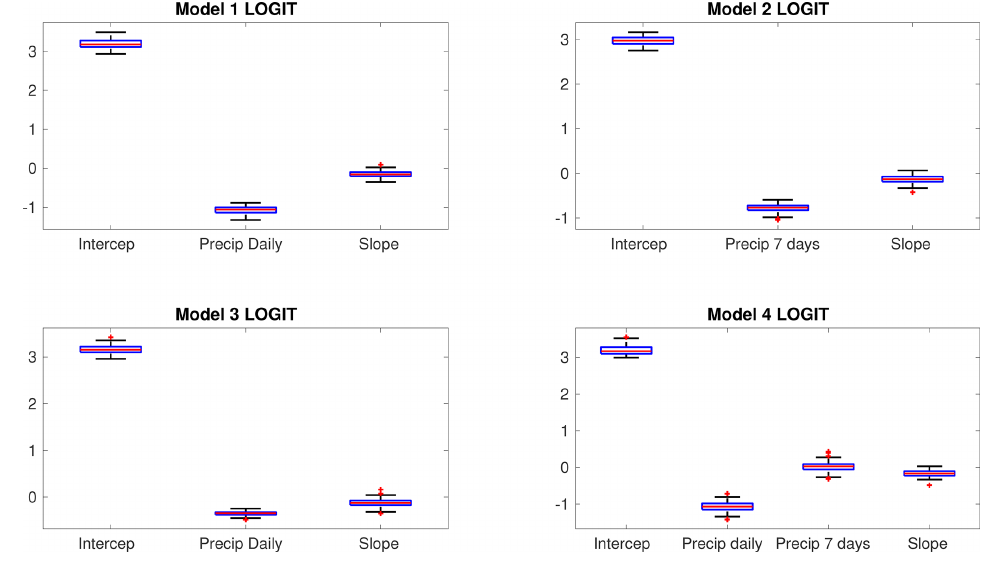
Figure 5. Distribution of estimators for each model with logit distribution.